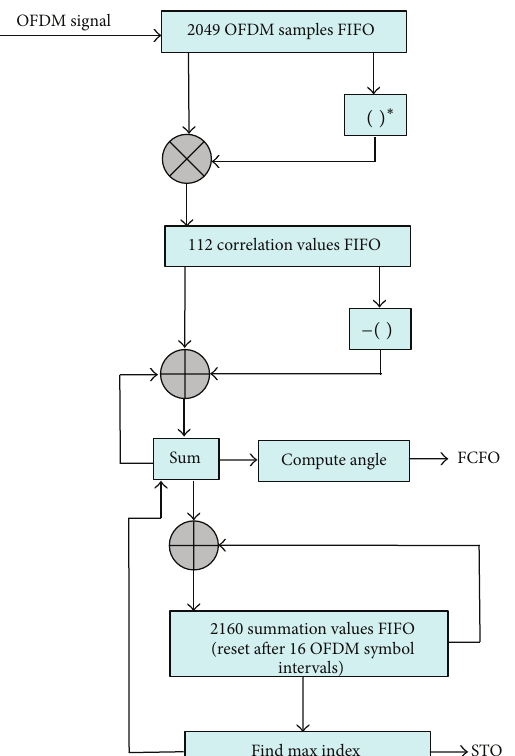
Figure 15: Flow chart of time synchronization and fractional fre- quency offset.